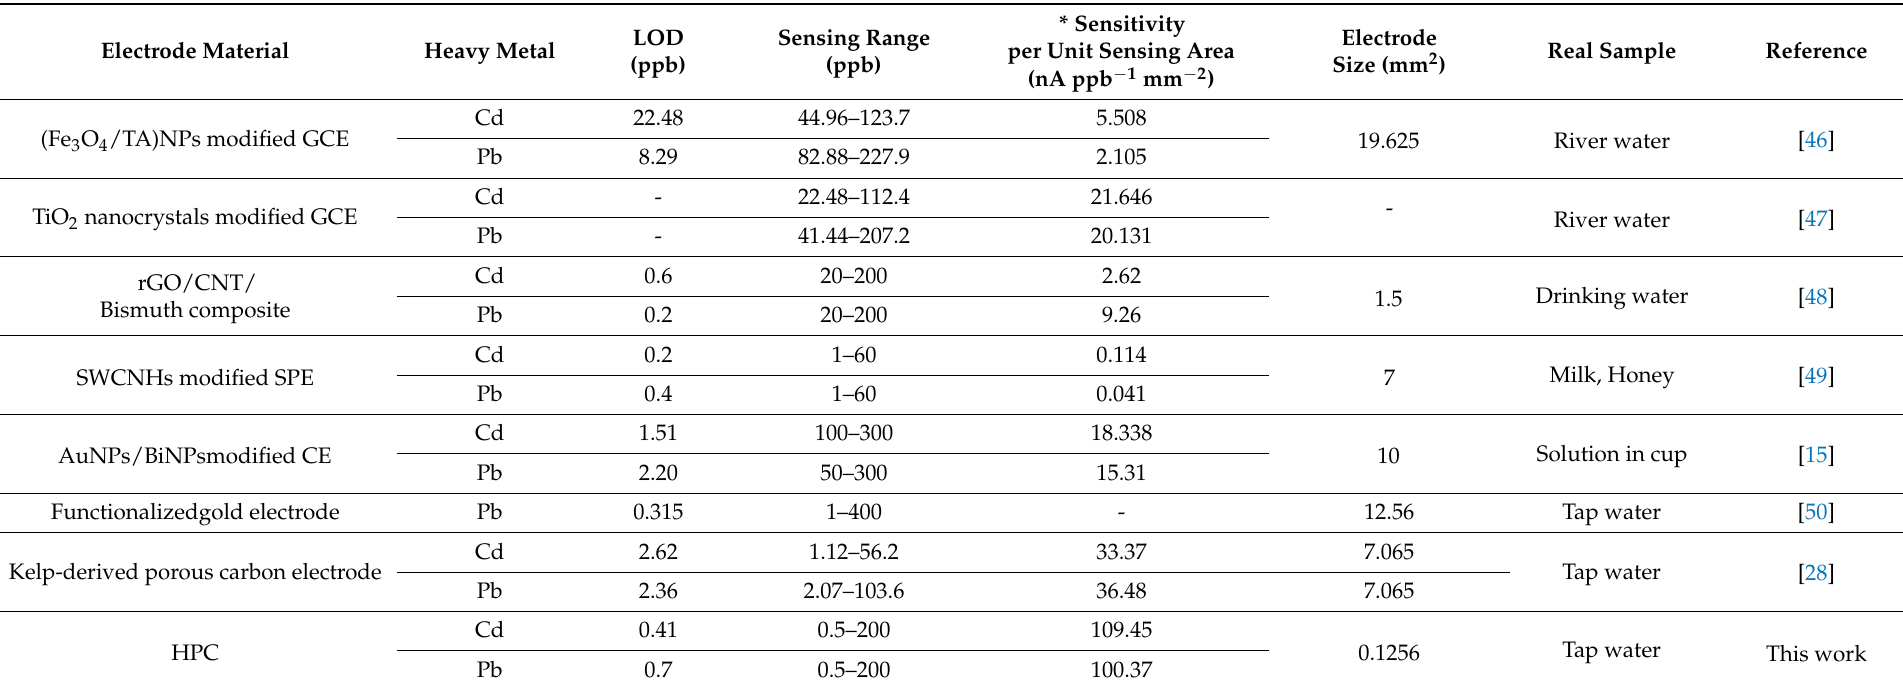
Table 2. Summary of the sensing performances of various heavy metal sensors, using SWASV